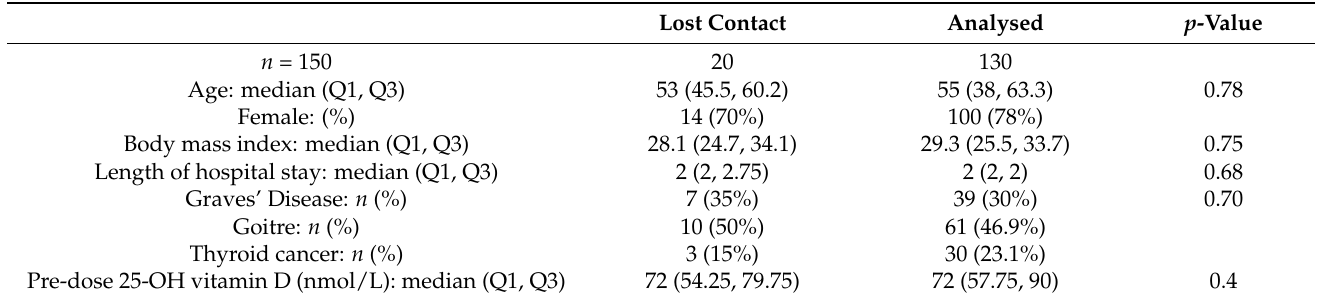
Table 2. Baseline characteristics: lost to follow-up vs. included in